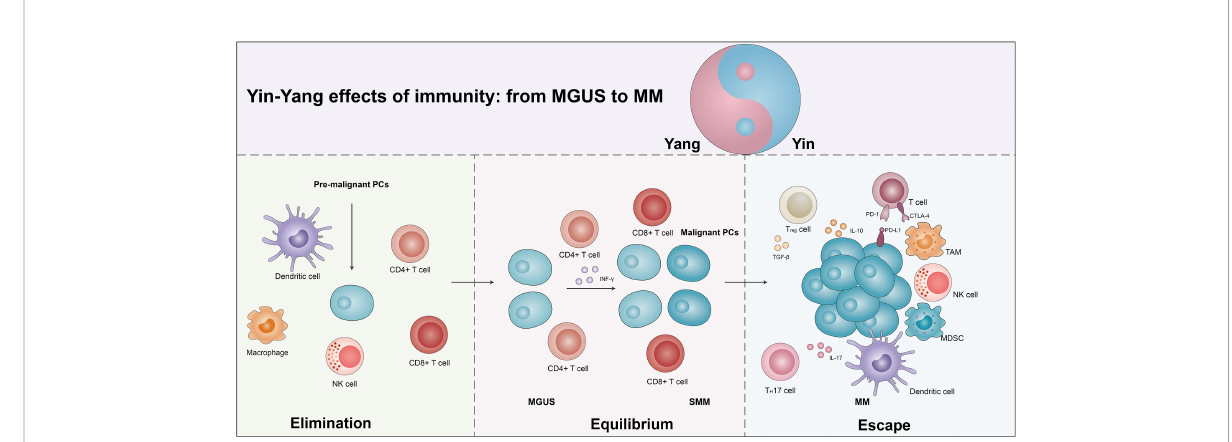
FIGURE 1 The yin and yang effects of immunity from MGUS to MM. As the body produces pre-malignant plasma cells (PCs), the immune system is activated and eliminated by the immune cells in a process known as the elimination phase, which manifests itself as a yang effect. However, if the elimination is incomplete, some of the pre-malignant PCs become malignant and the immune system enters an equilibrium phase with the tumor cells, which manifests clinically as MGUS/SMM. Due to the continuous immune stress selection, the tumor cells mutate and induce the tumor microenvironment into an immunosuppressive state, leading to the escape phase of the tumor cells. Exhaustion T cells, regulatory T cells (Tregs), suppressor dendritic cells (DCs), dysfunctional NK cells, T helper 17 (Th17) cells, tumor-associated macrophages (TAMs), and bone marrow-derived suppressor cells (MDSCs) promote escape and disease progression, manifesting as a yin effects. See text for detailed